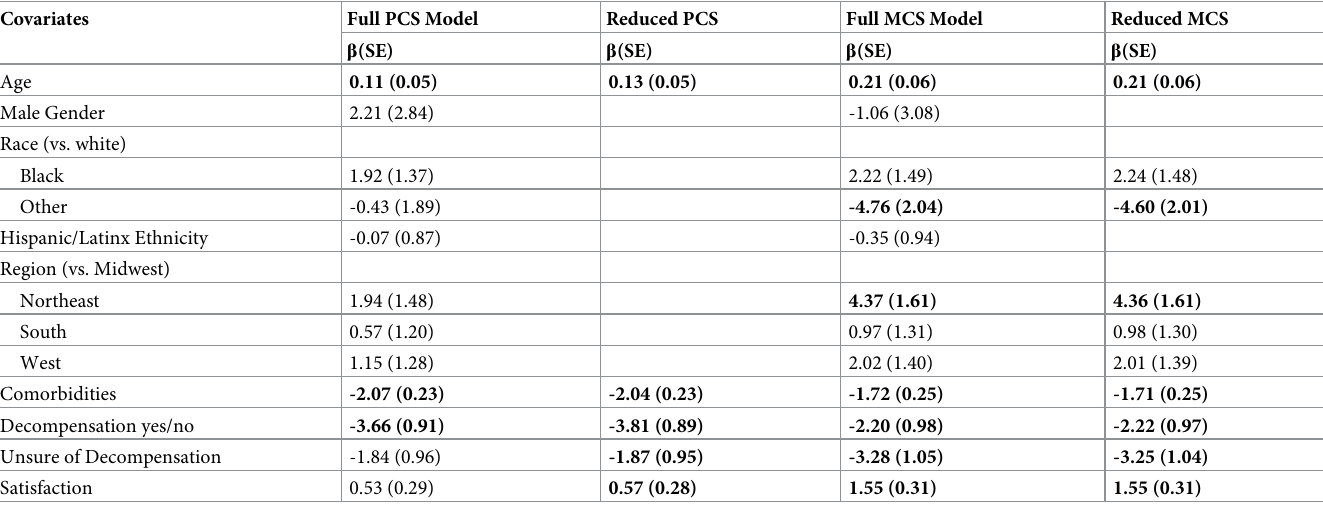
with care, and being unsure about cirrhosis symptoms. These novel connections between HRQoL and disease knowledge (being unsure about cirrhosis symptoms) and care satisfaction may provide new targets for intervention. Using a generic HRQoL instrument allows us to compare Veterans with cirrhosis to other disease populations. Persons with no chronic conditions have average physical and mental com- ponent scores of 50 and 56, and healthcare-seeking patients have average scores of PCS = 40 and MCS = 50 [12]. Thus, Veterans with cirrhosis had reduced QOL (PCS = 30 and MCS = 41). Table 5. Regression models of factors associated with HRQoL in